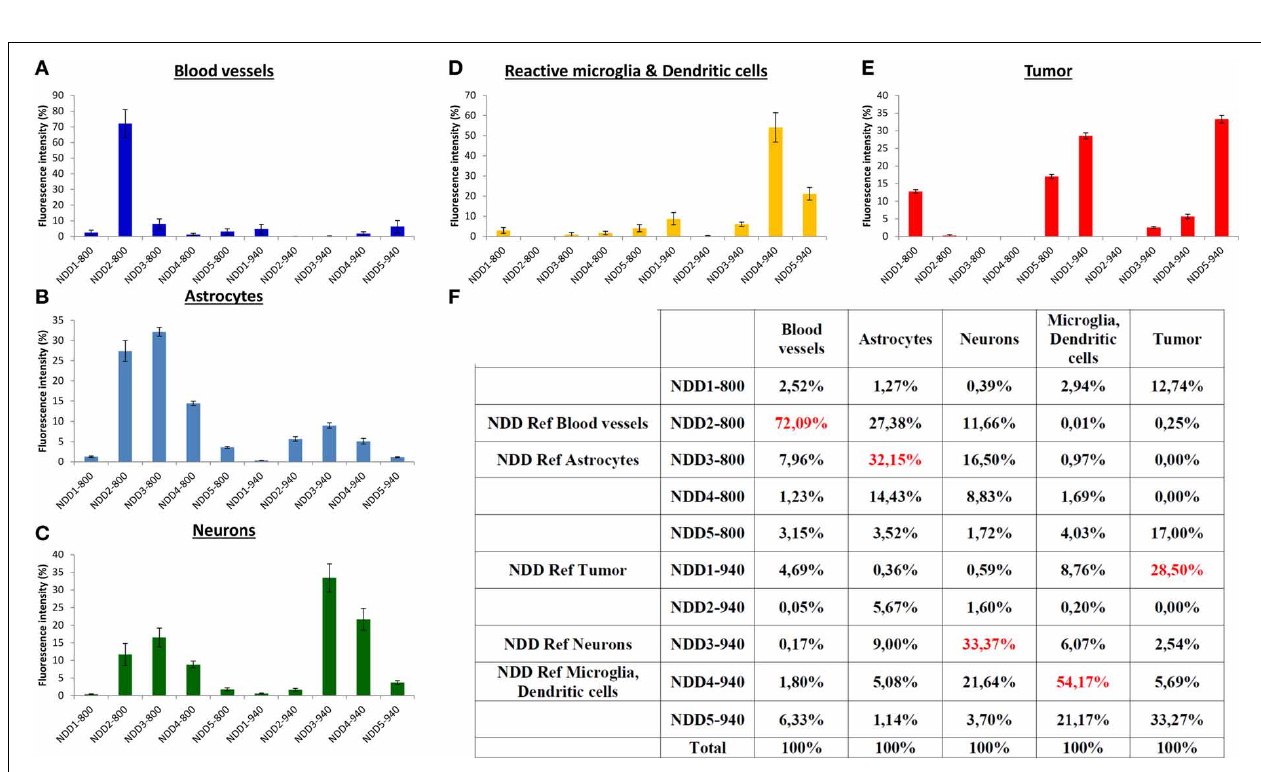
FIGURE 2 | Normalized spectral signatures of each biological element on the non-descanned detectors array. (A–E) normalized (%) contribution of each element on the NDDs for excitations at 800nm (NDD1-800–NDD5-800)